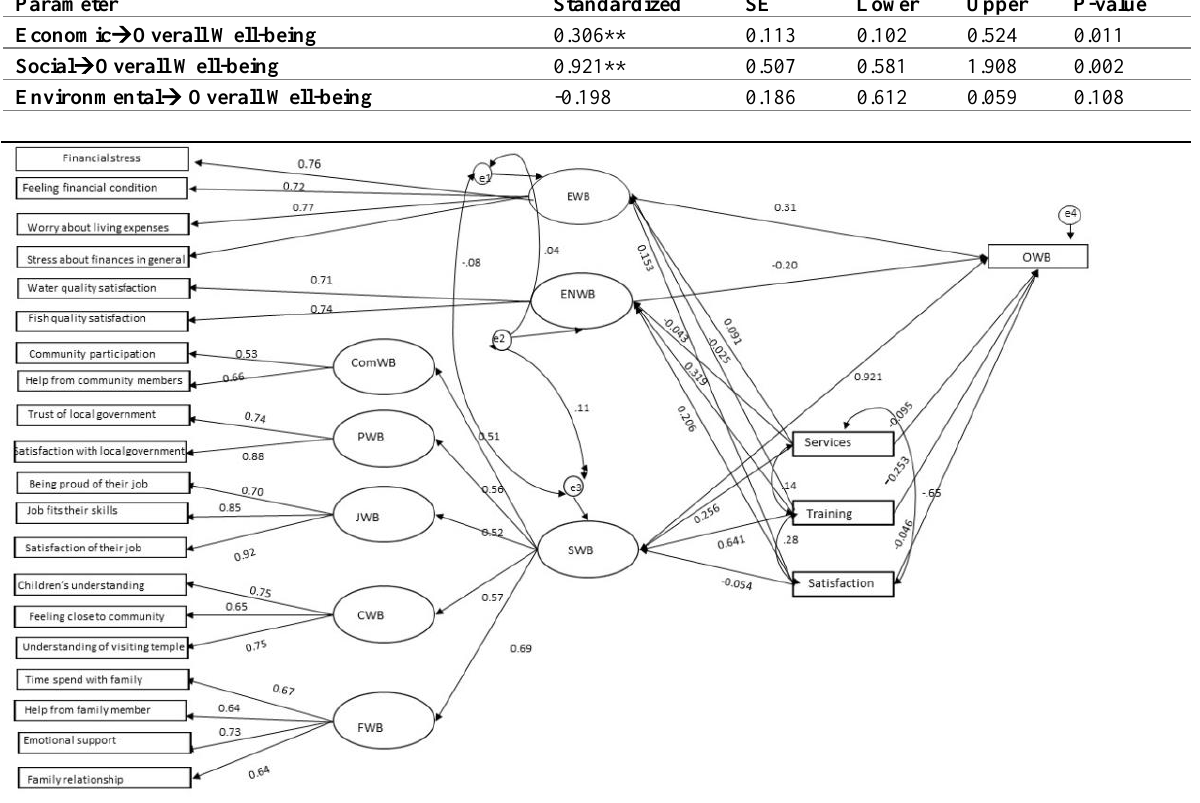
Figure 2: Path diagram showing measurement and structural model (Chaiyamart,